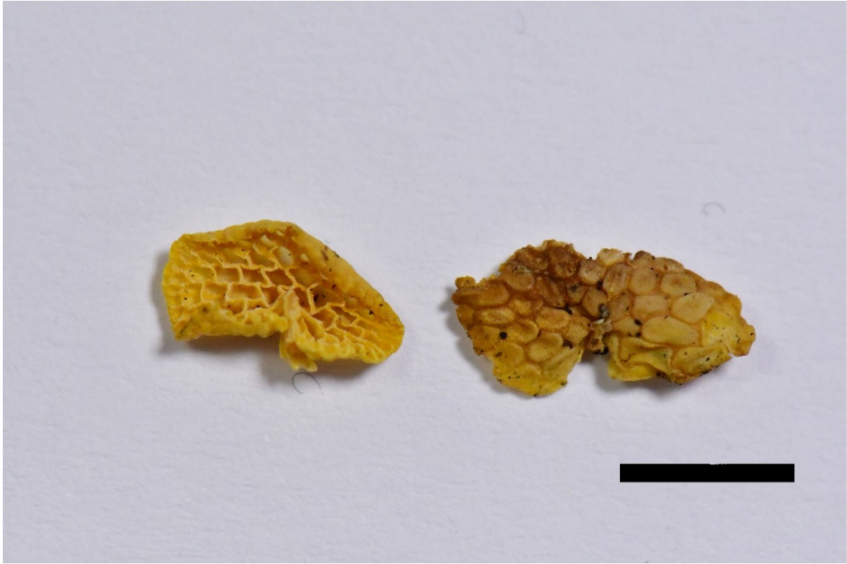
Figure 6. Dried basidiocarps of Favolaschia brevistipitata (Holotype). Scale bar = 5